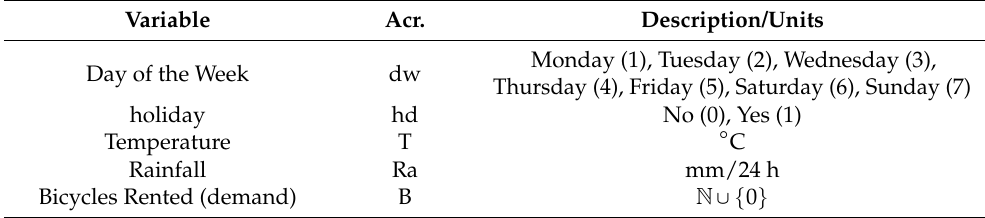
Table 2. Variables involved in BiciMad’s bike-sharing demand prediction problem.